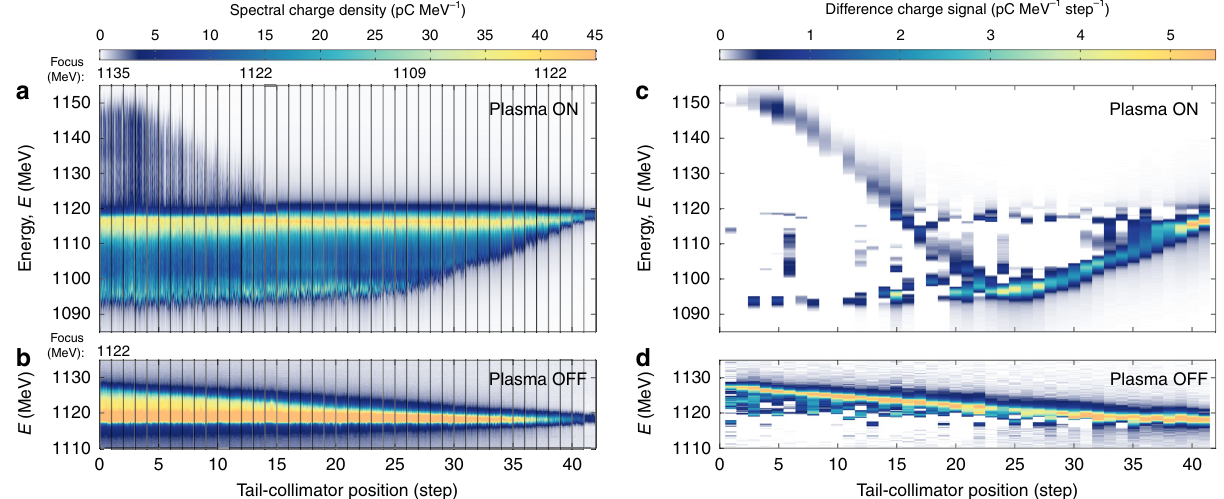
Fig. 3 Evolution of the tail-collimated energy spectrum. a As the tail collimator is moved in (horizontal axis), the tail particles are progressively removed from the plasma-interacted energy spectrum; 70 shots are collected per step. b The same scan is repeated with no plasma (20 shots per step), demonstrating the energy collimation of the incoming bunch. c The difference of (averaged) spectra at consecutive collimator steps reveals the energy of each slice of the plasma-interacted bunch. d By subtracting the plasma-off energy of each slice, the wake fi eld signal can be